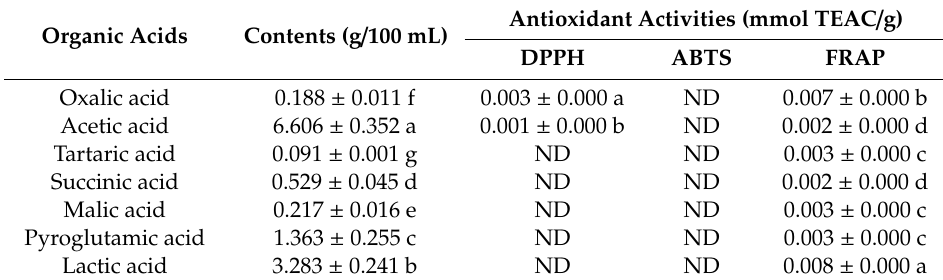
Table 2. Organic acid contents and antioxidant activities in ZAV-5 1,2,3 . Organic